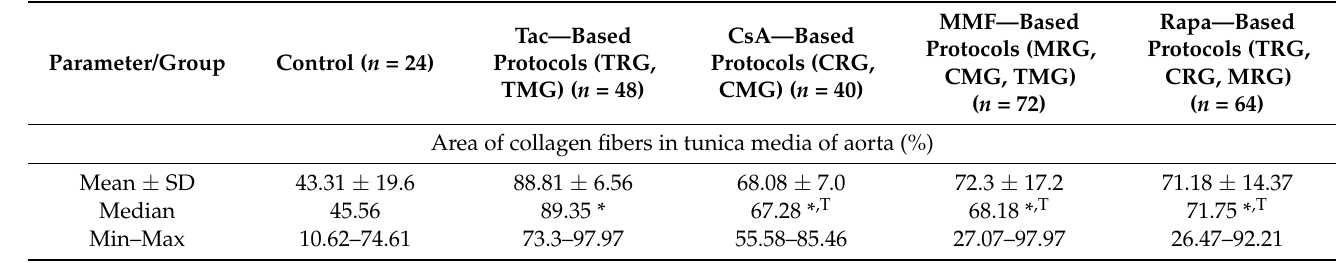
Table 3. Area of collagen fibers in tunica media of aorta due to main drug-based protocols.